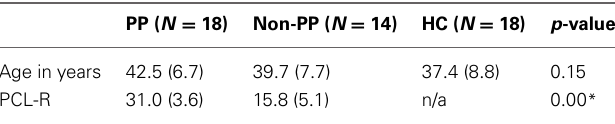
Table 1 | Sociodemographic and clinical characteristics of study participants (mean [ SD